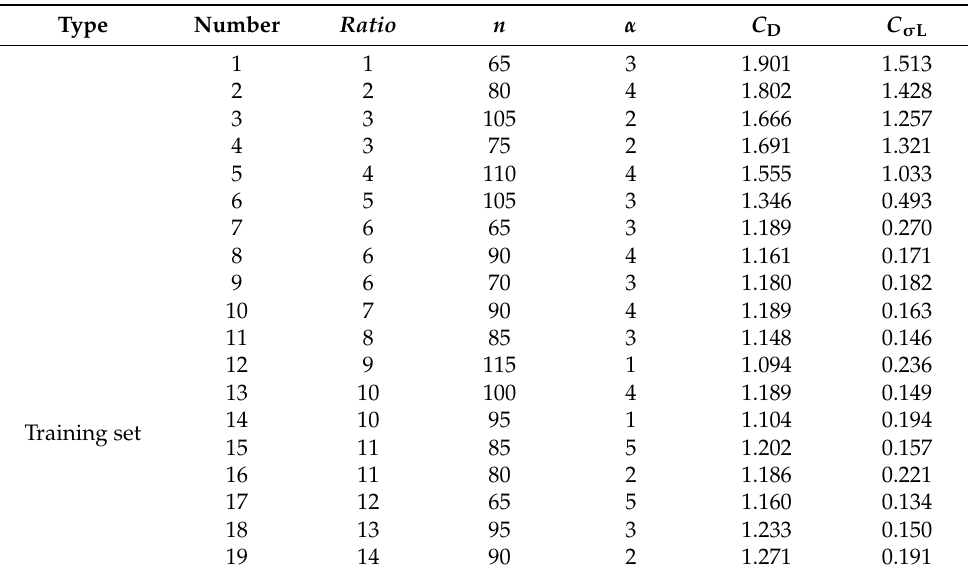
Table 1. Initial sample points of the corner recession square cylinders and the corresponding aerody- namic